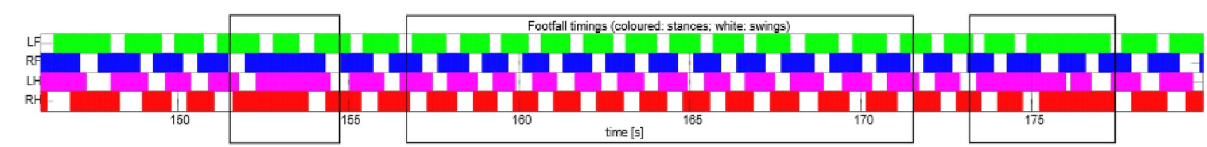
Fig 2. Footfall figure of selected interval of a measurement. Limbs are indicated by separate colors (green: LF, blue: RF, purple: LH, red: RH); colored areas indicate stances and white areas indicate swing phases as adapted from horses [29]. The first box shows an excluded epoch in which three limbs have a prolonged stance duration compared with the LH limb, the second box indicates an included epoch of stride-by-stride regularity in which all limbs have comparable stance and swing durations and the third box indicates an excluded epoch in which three limbs have longer stance durations but not at the same moment in